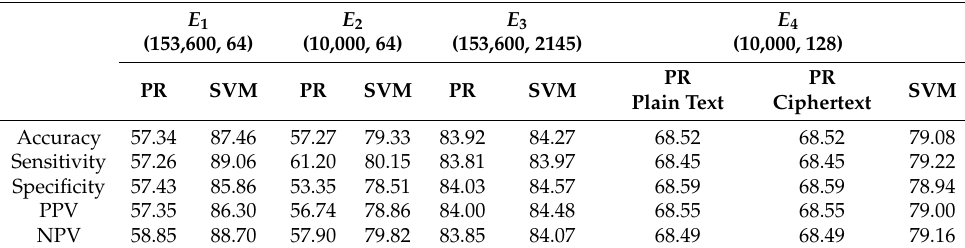
Table 4. Performance comparison when using different input data configurations in the EEG-based predisposition to alcoholism detection use case.